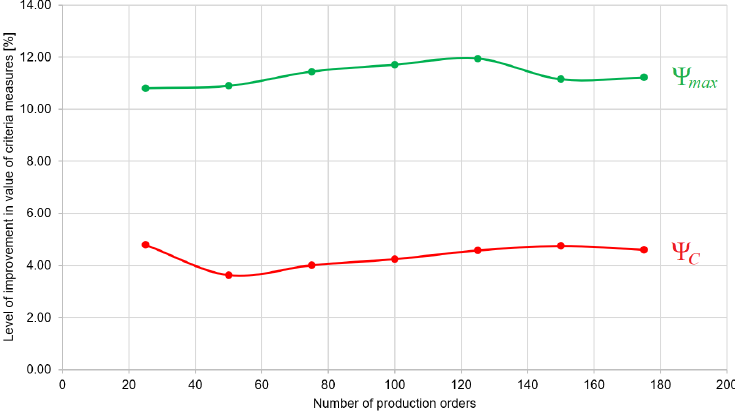
Figure 8. The effect of taking into account the influence of resources for the production of the scraper conveyor